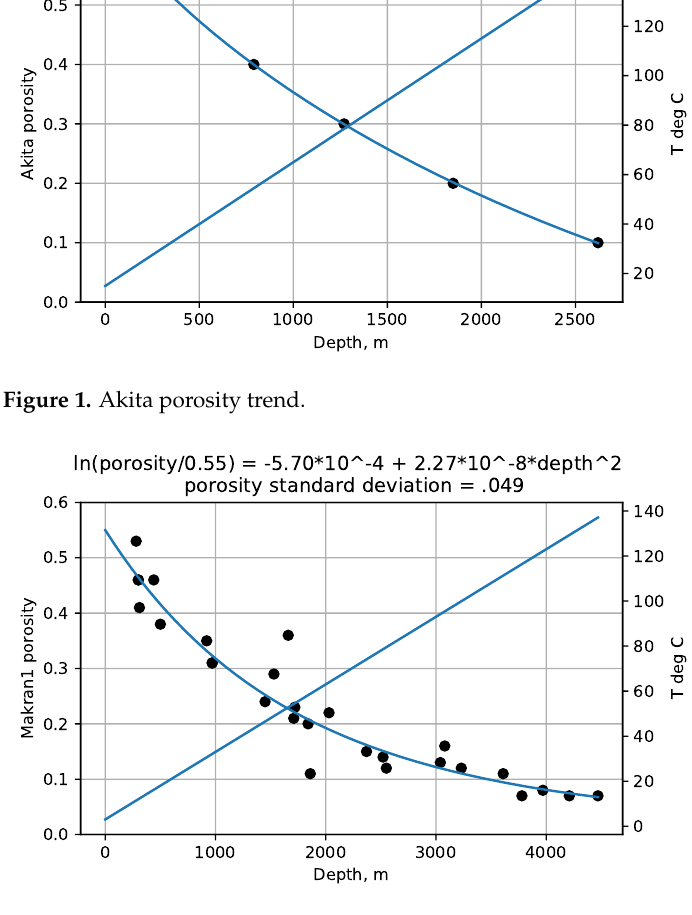
Figure 2. Macran1 porosity